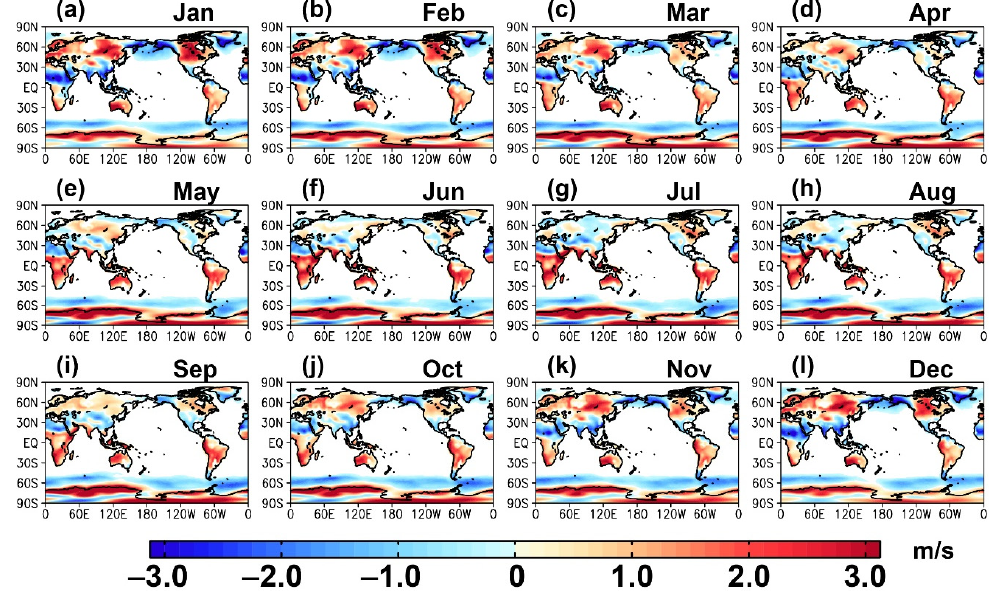
Figure 17. Same as Figure 15 but for the results derived from M3.